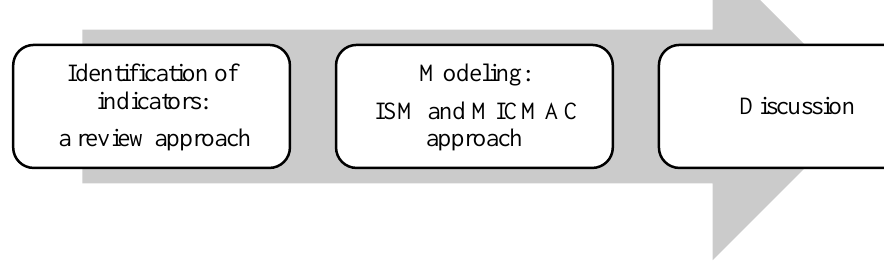
Figure 2. Research structure (Ref: Authors).